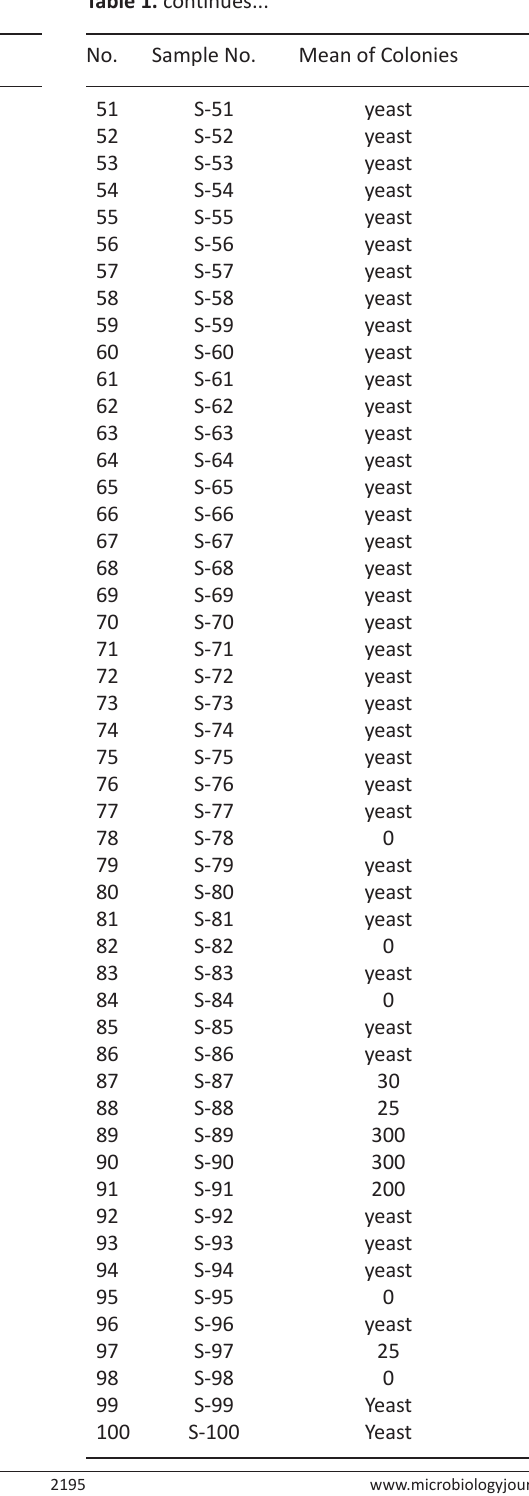
Table 1. Counting of bacterial colonies on the contaminated handles of car